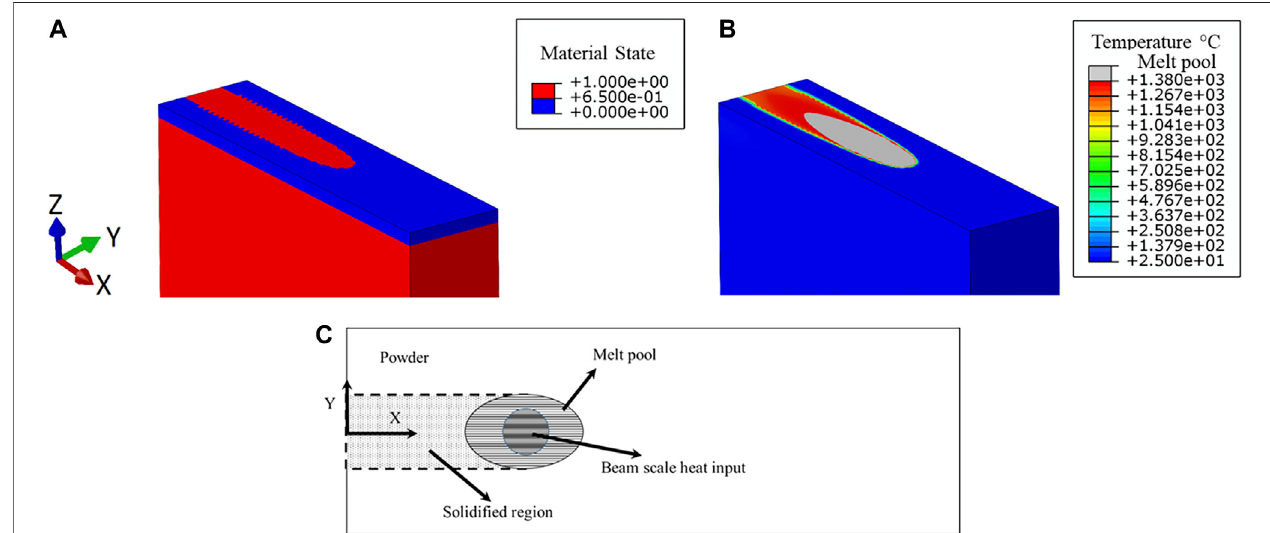
FIGURE4| EDmodelsimulationshowingthematerialstatetransitionandtemperaturedistribution.In (A) ,thepowder(blue)andliquid/solid(red)zonesareshown. (B) Nodal temperature during the process. In (C) , a schematic of the material state transition occurring in the melt pool is shown.